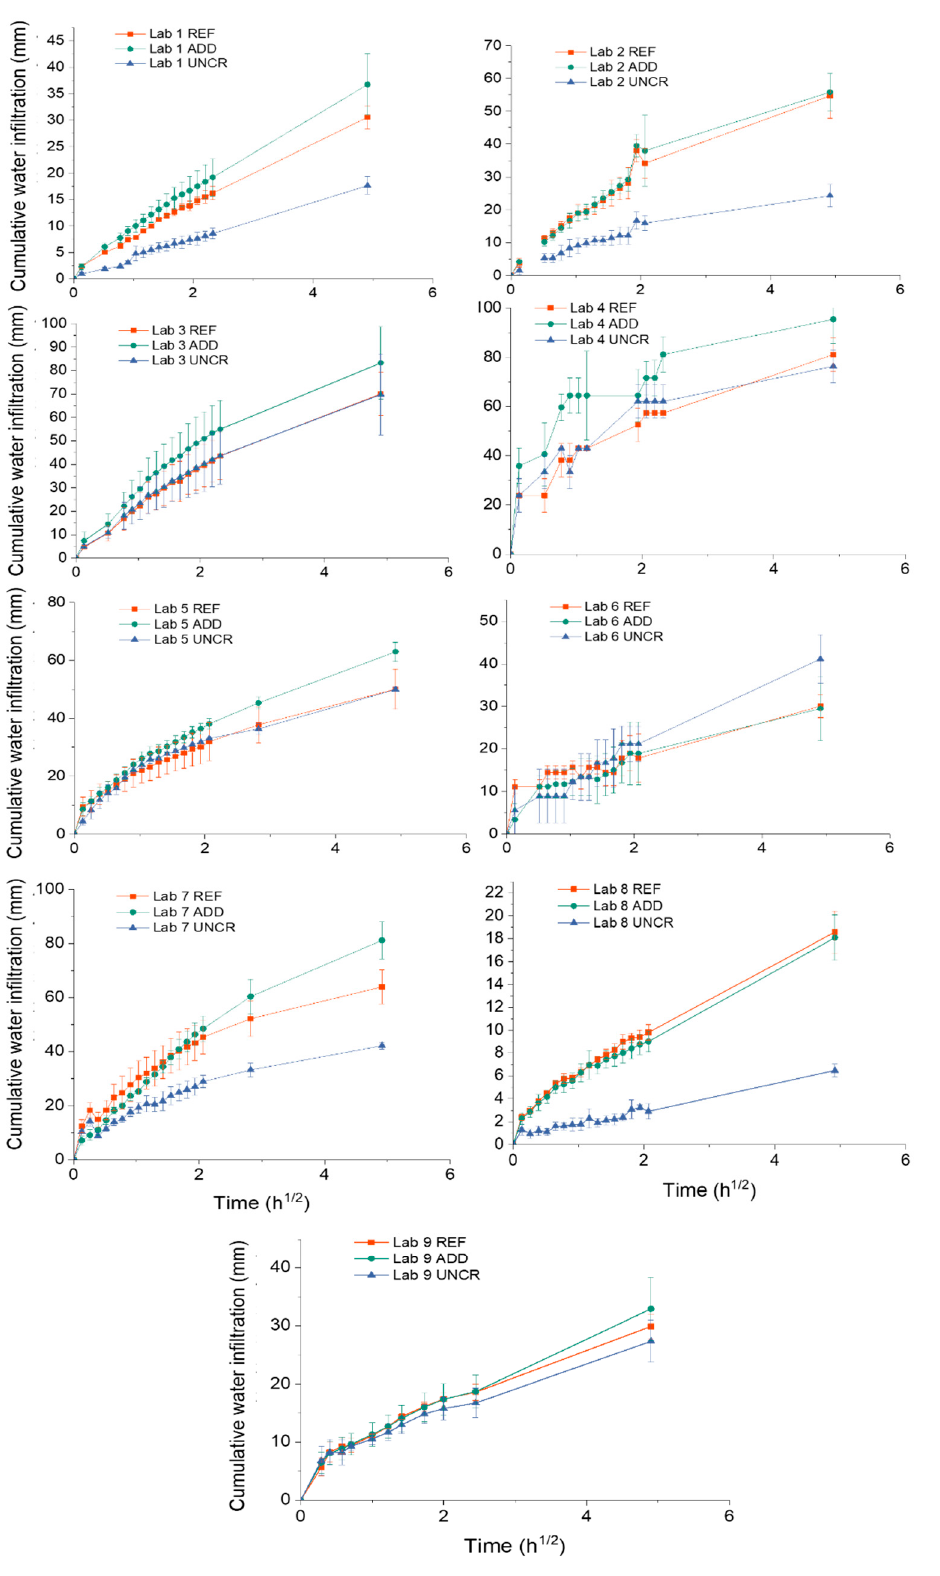
Figure 9. Cumulative water infiltration versus the square root of time of REF, ADD, and UNCR specimens (waterproofed with aluminium tape) of all nine labs. Error bars indicate the standard deviation.